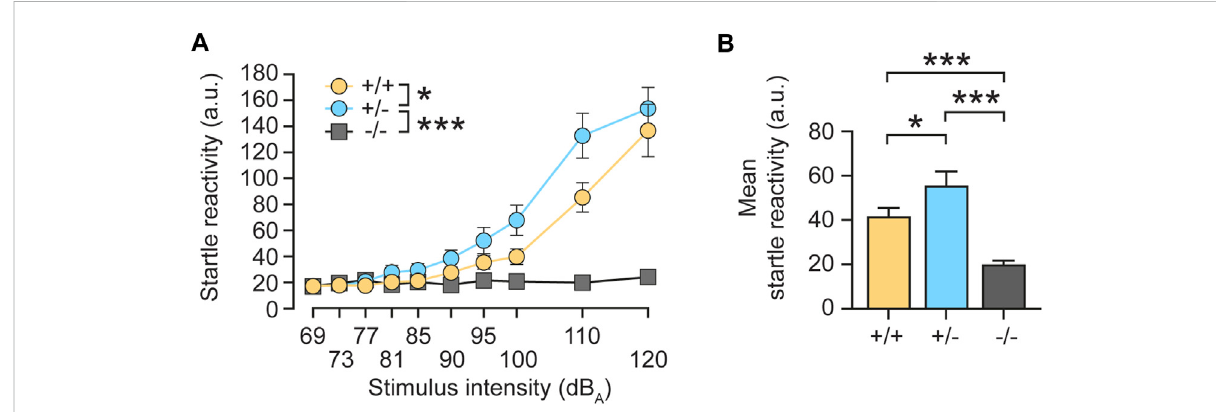
Monoallelic loss of rdx increases the acoustic startle re fl ex in mice. (A) The intensity of the startle reaction (average of 10 trials, arbitrary units (a.u.)) expressed as a function of stimulus intensity. Rdx knockout ( − / − ) mice displayed no startle reactivity during increasing stimulus intensities, as compared to wild-type (+/+) or heterozygote (+/-) animals. The startle responses of heterozygotes (+/-) revealed higher overall startle reactivity compared to wildtype (+/+) controls above 81 dB A . (B) Mean startle reactivity across all stimulus intensities shown in (A) . Data were obtained from n = 16 (+/+), 16 (+/-) and 16 ( − / − ) adult rdx knockout mice, with equal numbers of males and females for each genotype. ANOVA was used to assess statistical signi fi cance. * p < 0.05, *** p < 0.001. Data represent mean ±